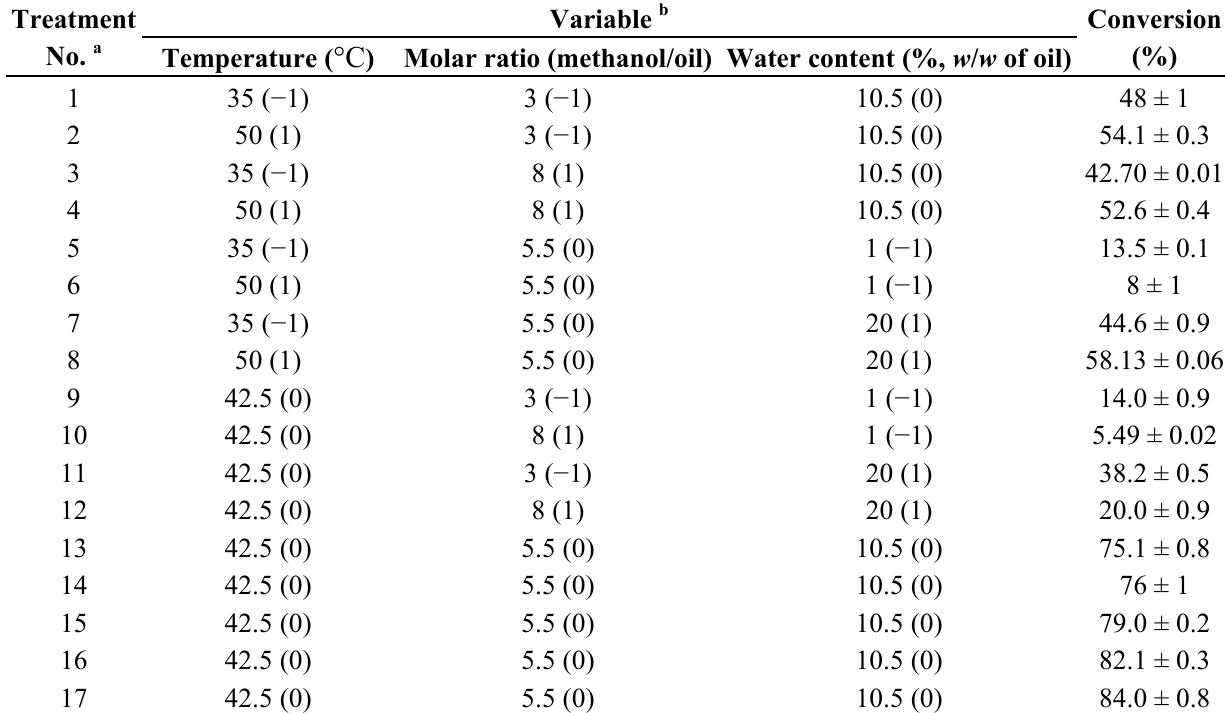
Table 1. Three-level-three-factor Box-Behnken design of experiments and the corresponding conversions.